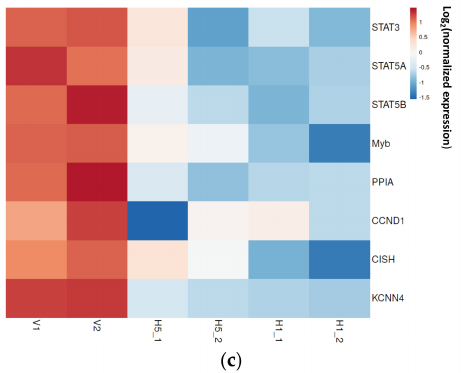
Figure 2. MetaCore pathways downregulated by 8-OHD treatment in K562 cells. ( a ) The top 15 significantly enriched pathways according to the MetaCore bioinformatics suite in response to 8-OHD treatment. ( b ) The MetaCore pathway map “Prolacin JAK2 signaling in breast cancer” was obtained by functional analysis of 1910 downregulated differentially expressed genes (DEGs) in response to 8-OHD. The blue thermometer indicates downregulated genes, and the thermometer level represents the intensity of the log 2 (fold change). Image generated using MetaCore. ( c ) Heatmap of expression patterns of Prolacin JAK2 signaling-associated genes in response to 8-OHD. H5 and H1 represent 50 and 100 µ M 8-OHD, respectively.